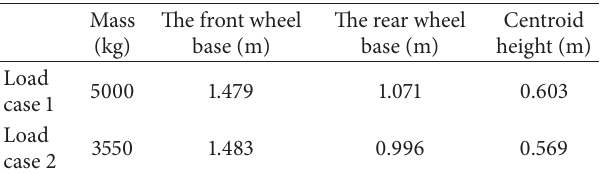
Table 1: The load